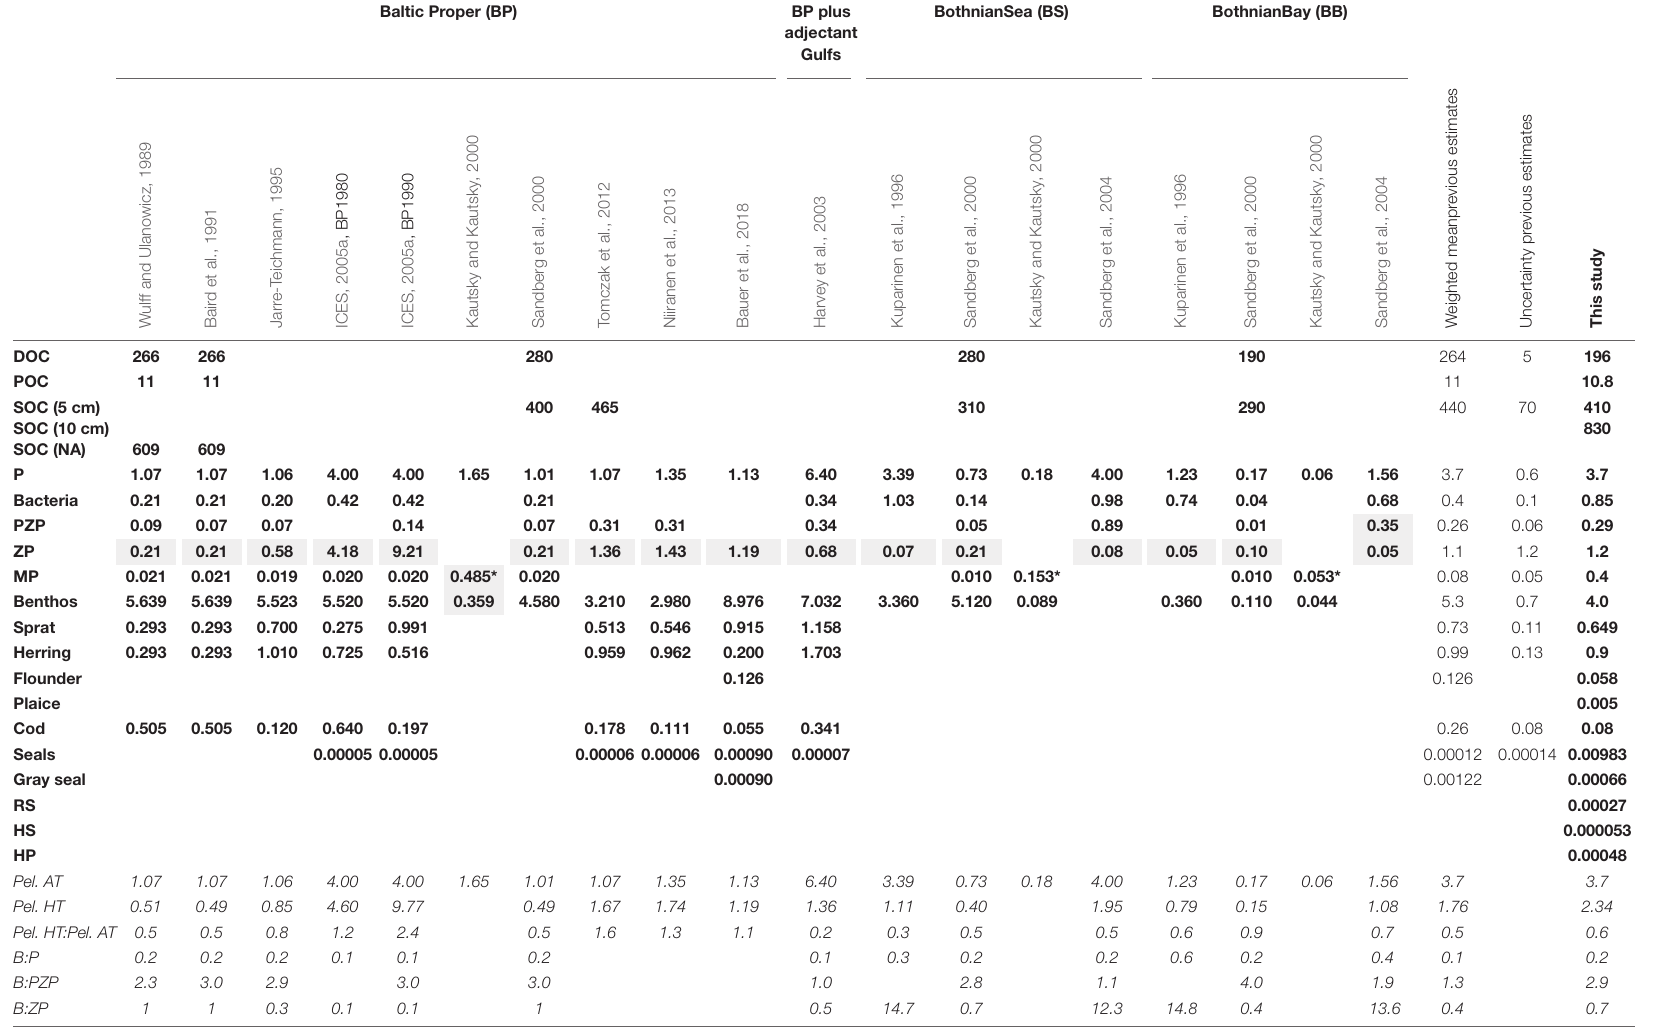
TABLE 3 | Basin-specific estimates from previous studies compared to our stock